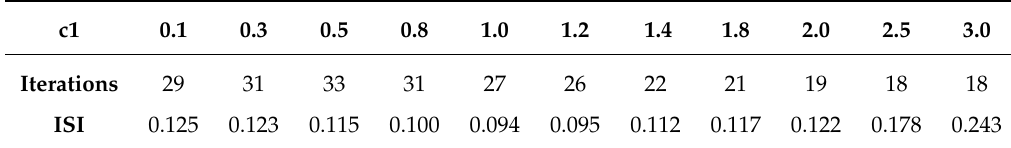
Table 2. The separation performance with varying c 1